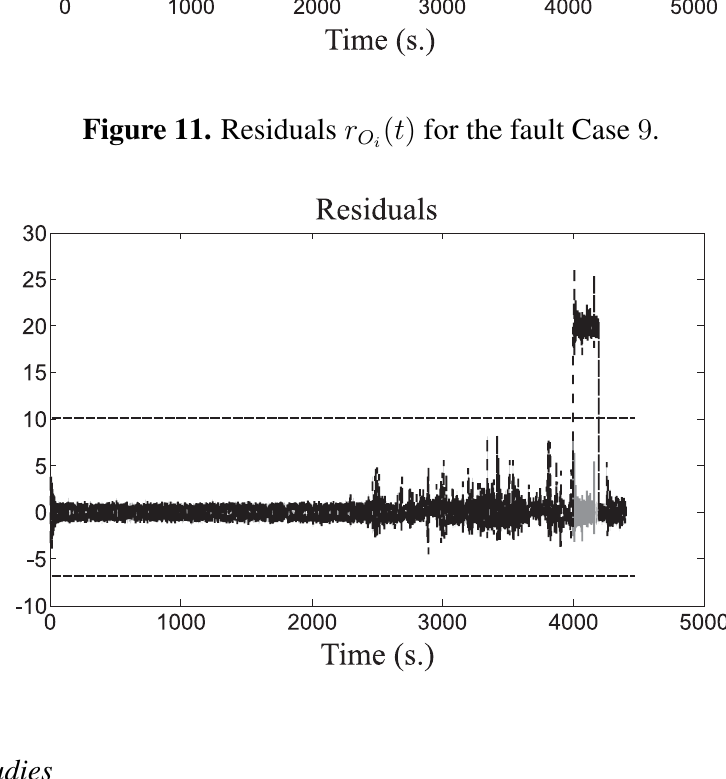
Figure 11. Residuals r